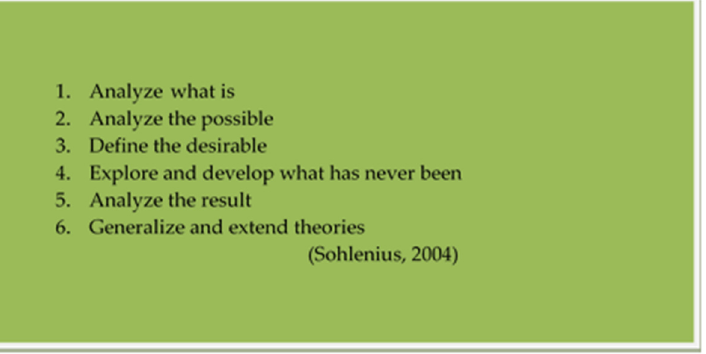
Figure 3. Scientific method for research and development in the area of science of engineering [32].